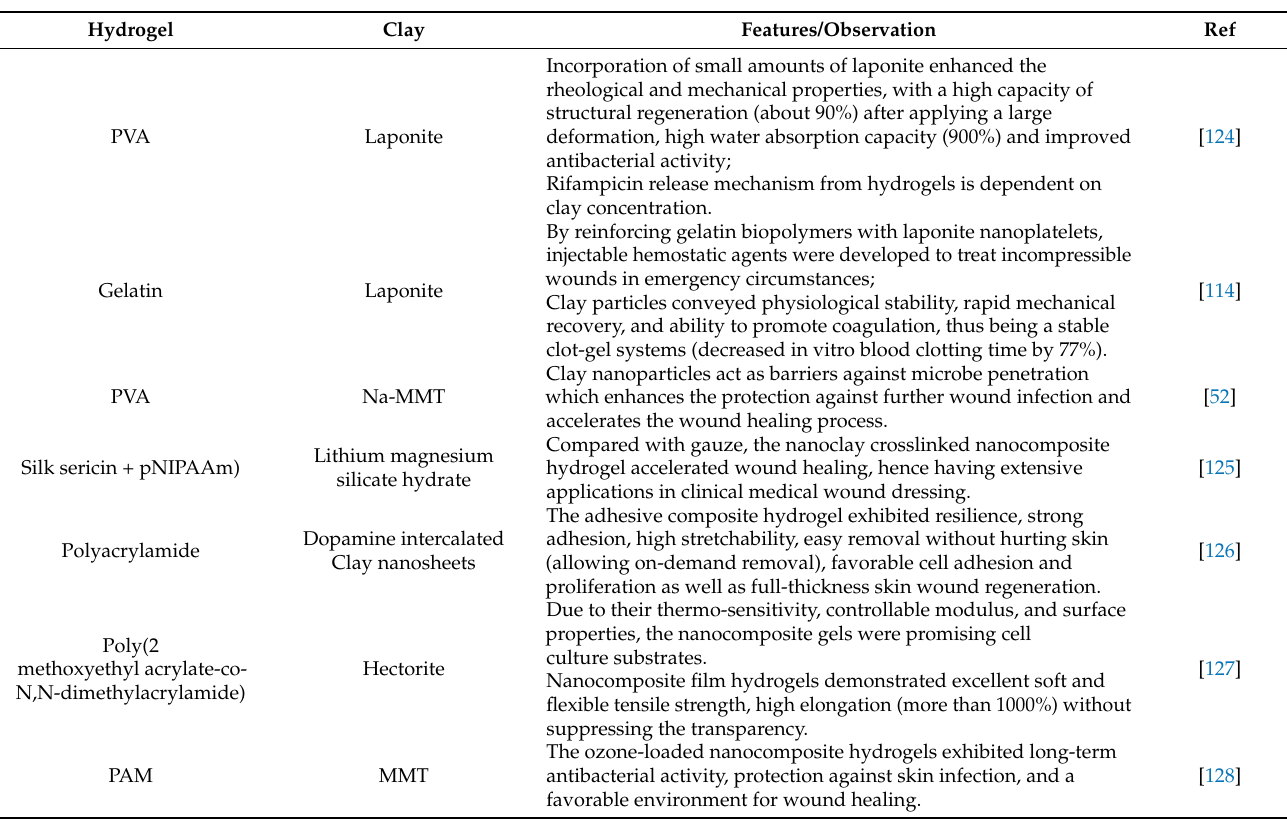
Table 5. Clay nanoparticles in hydrogel nanocomposites for wound healing applications.